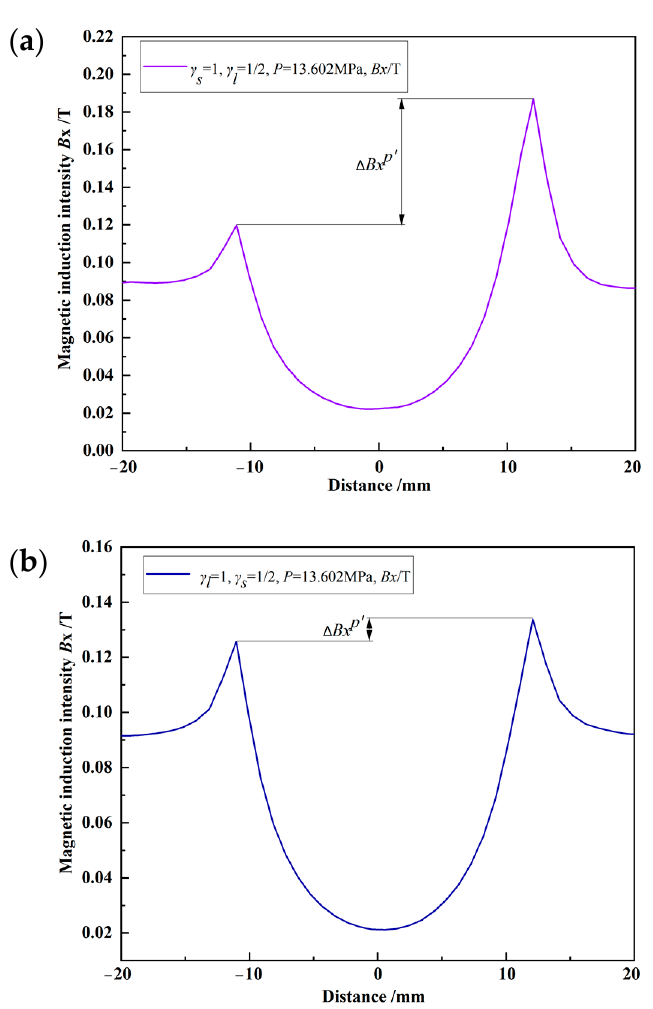
= 1 ， 𝛾 = 1 = , ( b ) 𝛾 (cid:3046) (cid:3039) (cid:3039) 2 , 1 2 = 1 ， 𝛾 = = , ( b ) 𝛾 (cid:3046) (cid:3039) (cid:3039) 2